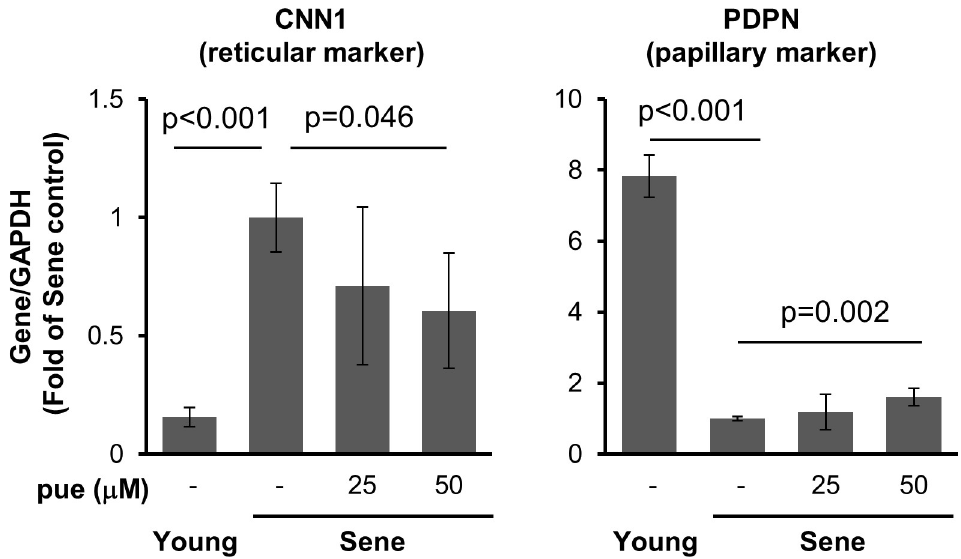
Fig 5. The effect of puerarin on gene expressions of reticular and papillary markers. The expressions of PDPN (papillary marker), CNN1 (reticular marker) in young and senescent NHDFs treated with or without 25–50 μ M puerarin (pue) for 72 h. n =